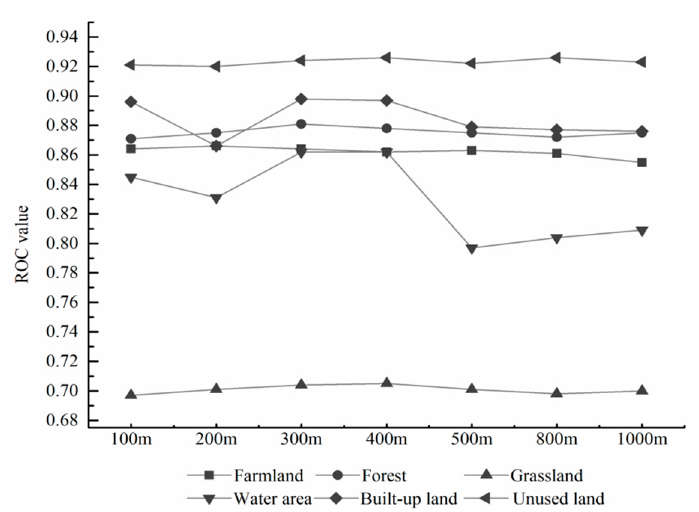
ff erent modeling